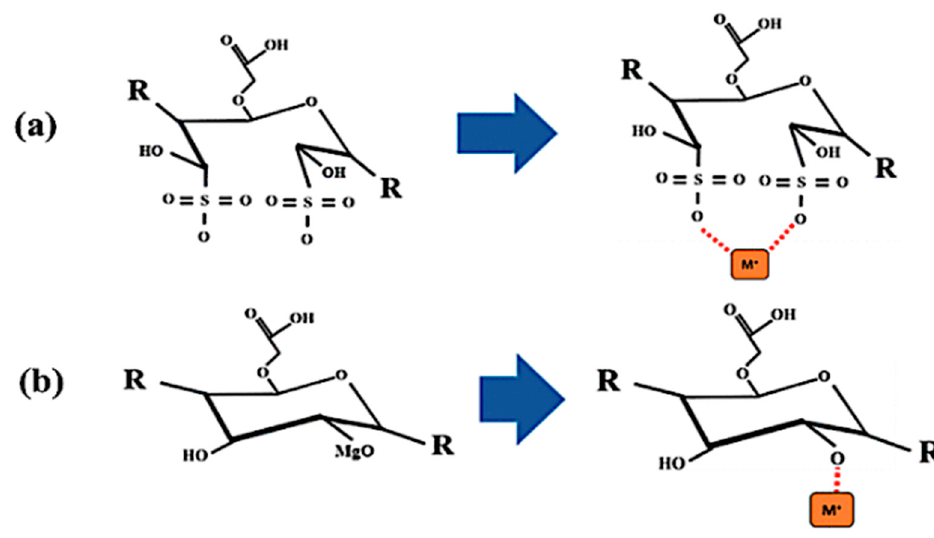
Figure 16. Adsorption mechanism on FeNP/NFC: ( a ) sulfur forms complexes and ( b ) ionic bonds. The exchange of metal ions (M 2 ) with H + ions of hydroxyl groups on the surface oc- curs because the cations in the aqueous solutions are hydrated; therefore, they are at- tracted to the surface’s functional group of interest. Mg 2+ can participate in the adsorption.